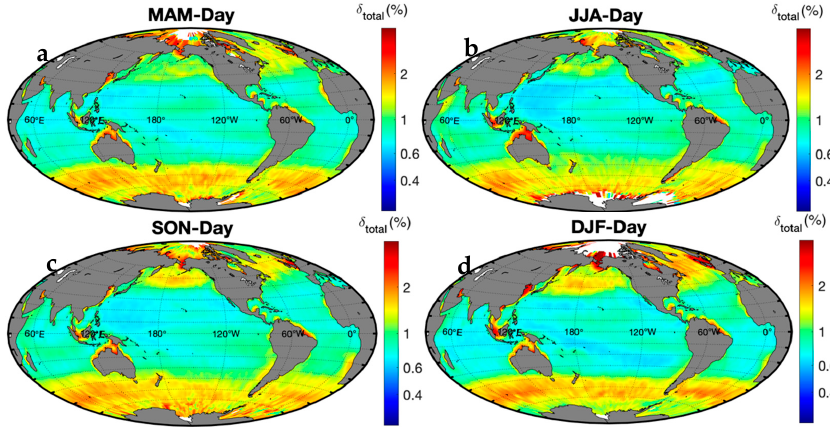
Figure 4. Same with Figure 3 but for daytime results before crosstalk correction.